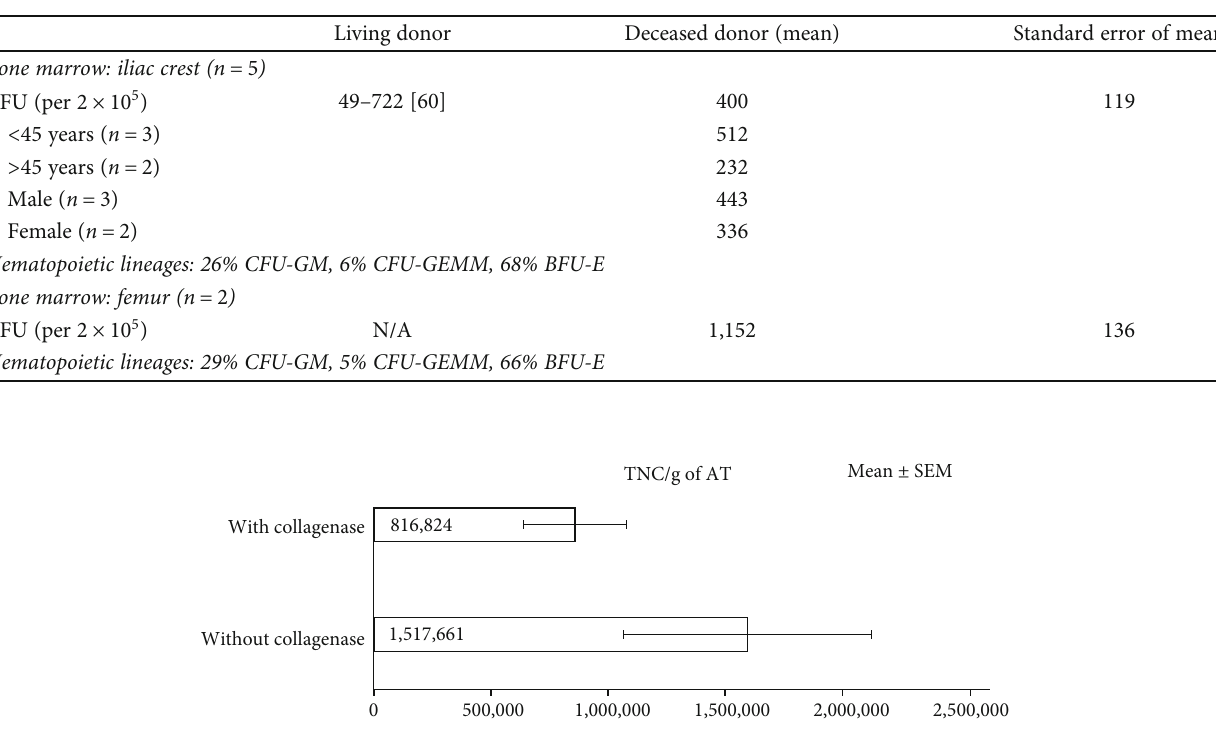
Figure 3: Comparison of mean total nucleated cells in the SVF per gram (TNC/g) of adipose tissue when treated with and without collagenase ( n = 6 , p value =